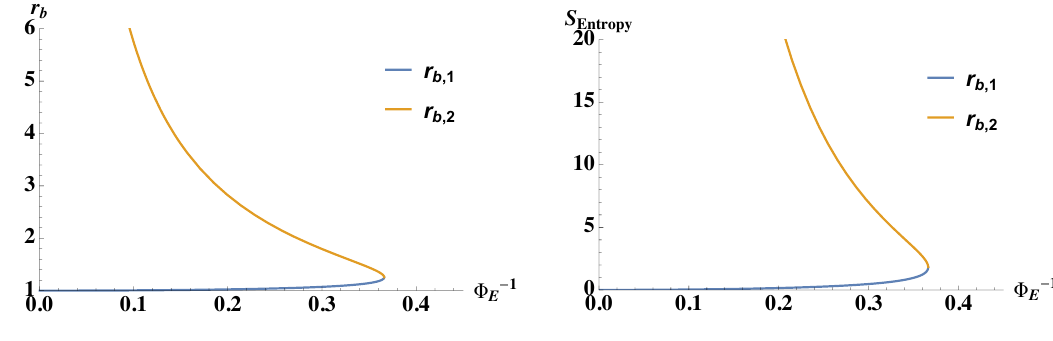
Figure 7 . Left: TB-AdS radius vs. Φ E − 1 . Right: entropy vs. Φ E − 1 for the extremal TB-AdS for a fixed value of χ and κ = 1 with G = l = 1 .